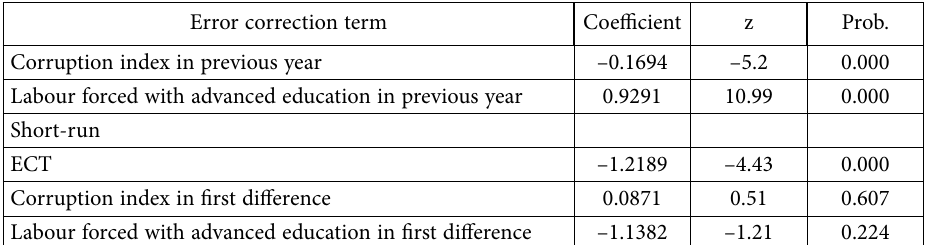
Table 10. Panel ARDL model to explain FDI in V4 countries (2005–2016) (source: own